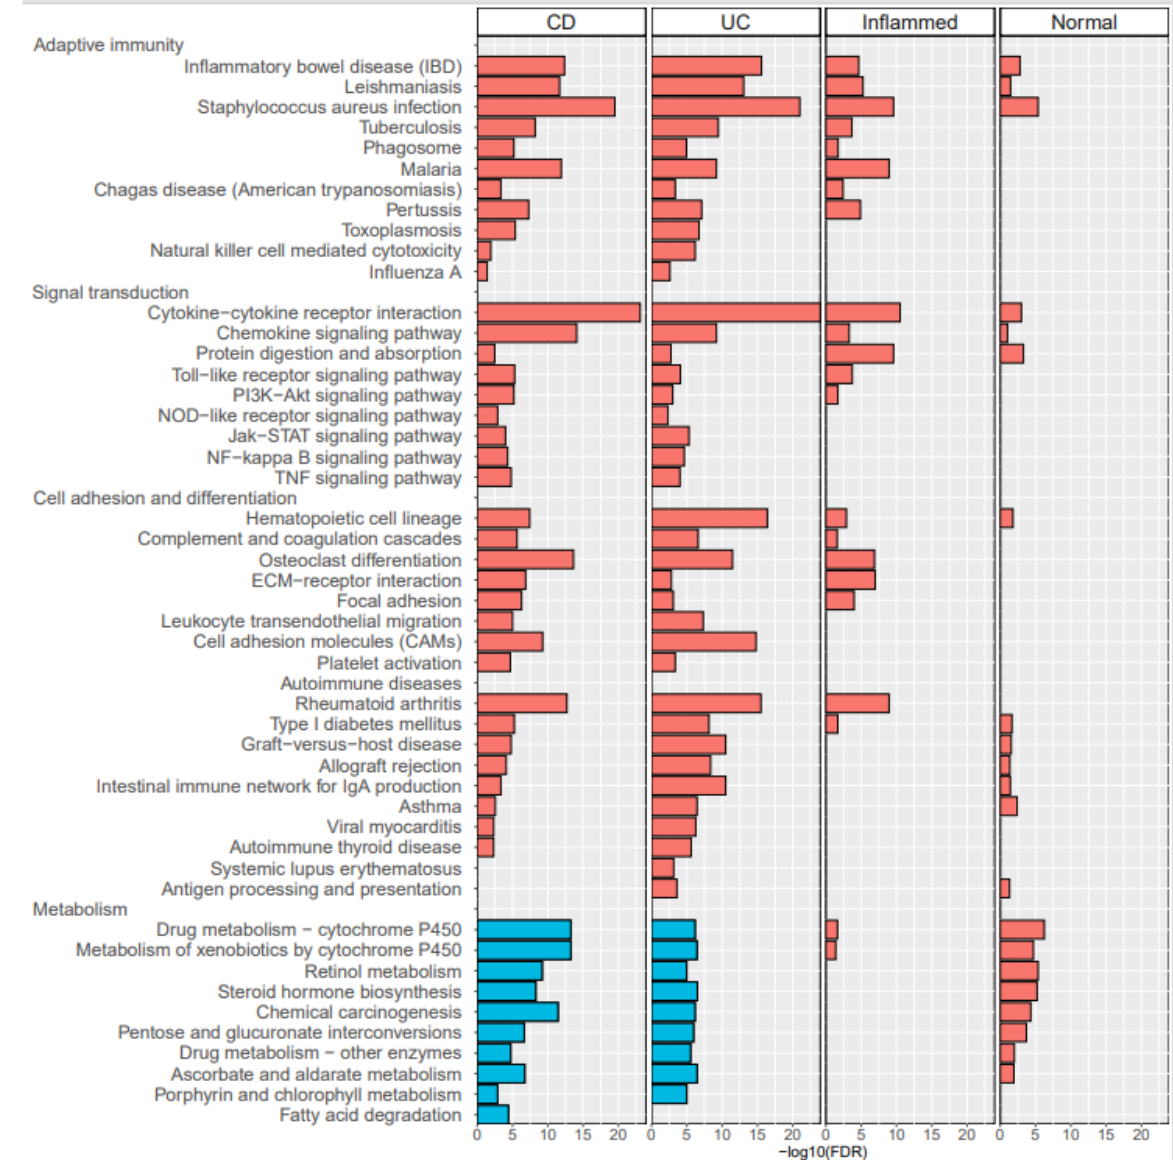
Figure 2. KEGG pathways enriched in the lists of differentially expressed genes (DEGs). The four panels correspond to the DEGs of inflammatory CD vs. normal CD (labeled “CD”), inflammatory UC vs. normal UC (labeled “UC”), inflammatory CD vs. inflammatory UC (labeled “Inflamed”), and normal CD vs. normal UC (labeled “Normal”). The horizontal bars represent the -log10(FDR) values from the pathway enrichment analysis calculated with DAVID web service (red for upregulated DEGs, and blue for downregulated DEGs). Note that the lists are shown for FDR < 0.05. There were no significantly enriched pathways for the downregulated genes of both “Inflammatory” and “Normal” panels. See Supplementary Table S3 for details of DEGs categorized to each pathway.